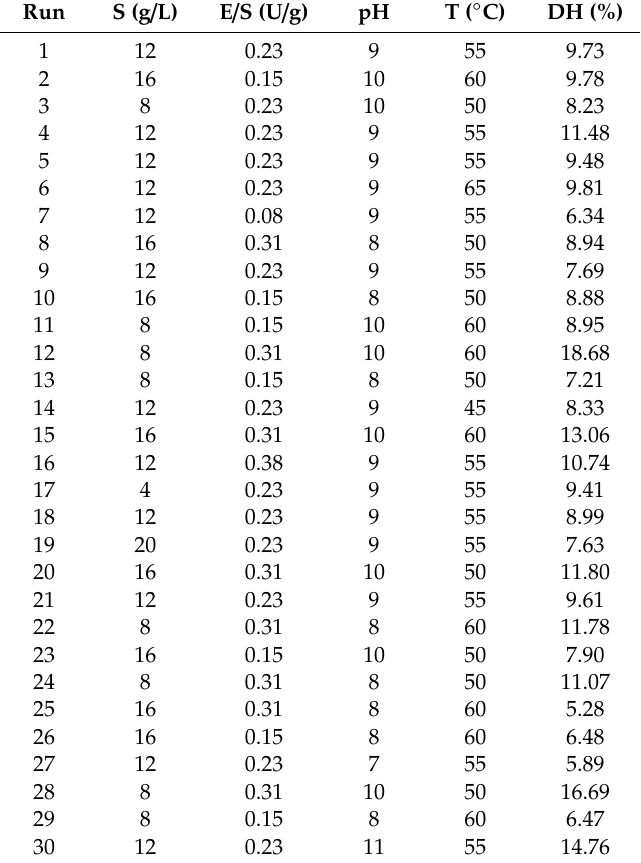
Table 1. Central composite rotatable surface response design for evaluation of the substrate concentration (S), enzyme substrate ratio (E / S), pH and temperature (T) S, E / S, pH, and T effect on the degree of hydrolysis degree of hydrolysis (DH) of red tilapia viscera (RTV) with Alcalase 2.4 L.